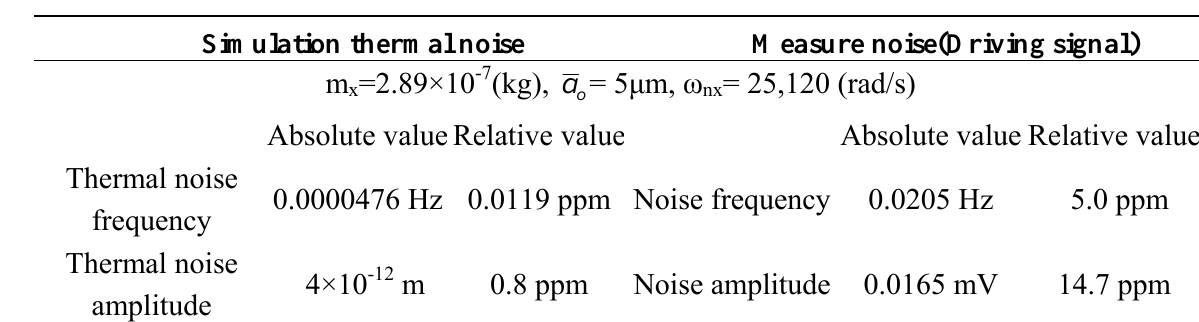
Table 2. The noise